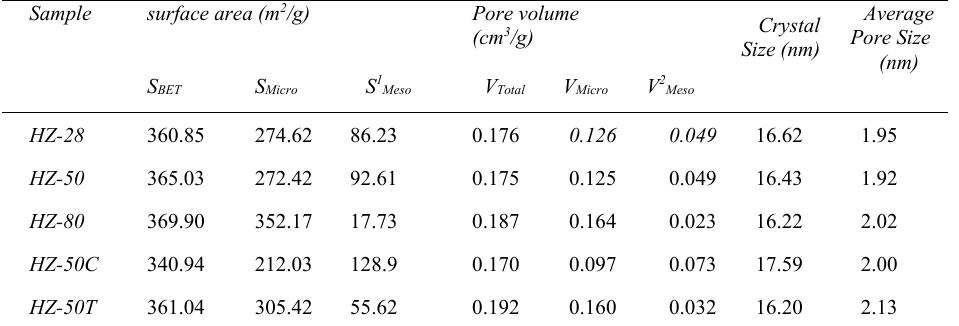
Table. 4. The textural properties of different samples Table 4. The textural properties of different samples.